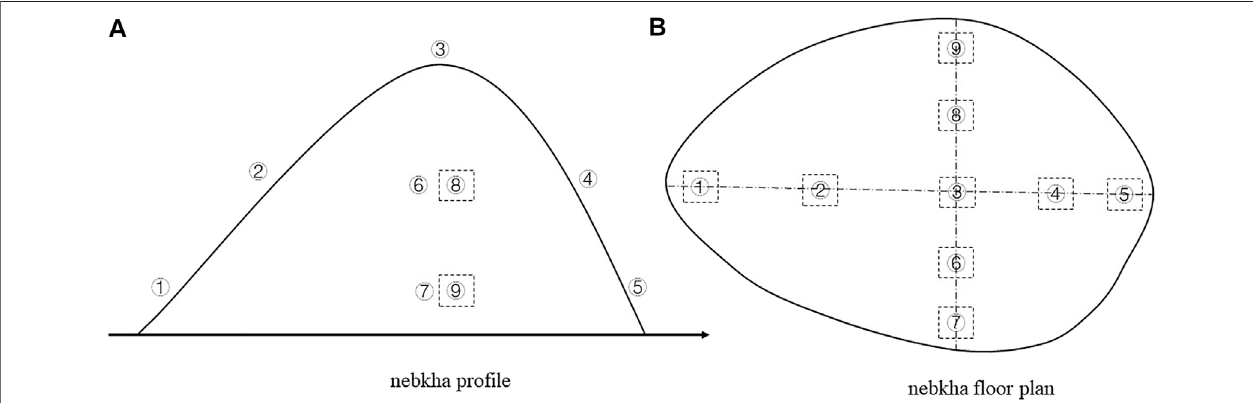
Frontiers in Environmental Science |